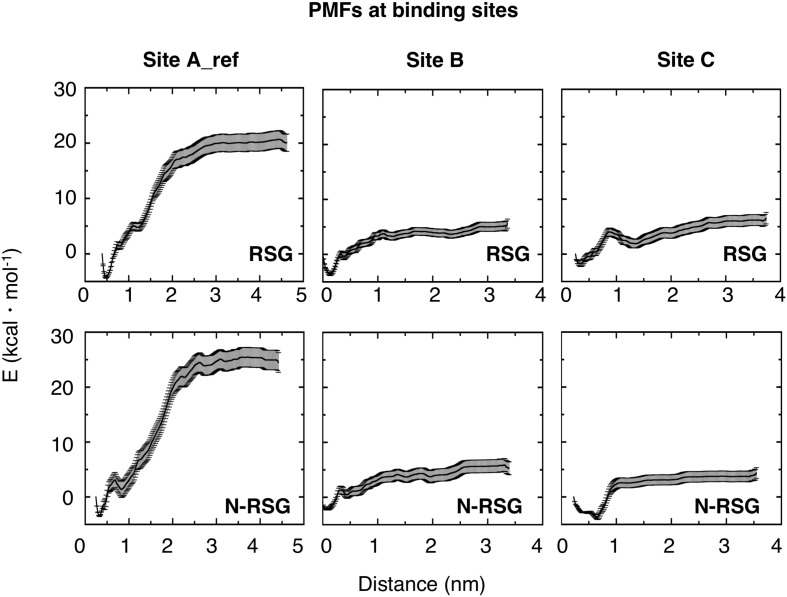
Potential of Mean Forces (PMFs) derived from US for both RSG and N-RSG at the three binding sites. The energy profiles are depicted including their standard deviations. The WHAM histograms are shown in Supplementary Figure S4. Site A_ref shows higher binding affinity for both, RSG and N-RSG, compared to the other binding sites.